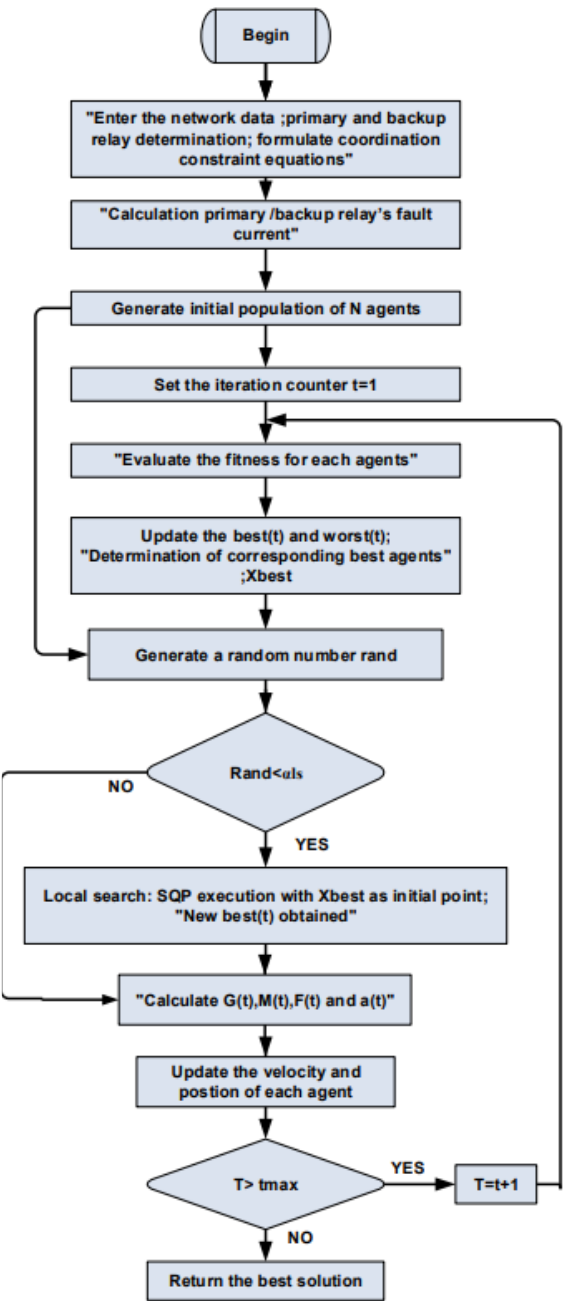
Figure 6. The flowchart of the GSA–SQP algorithm.